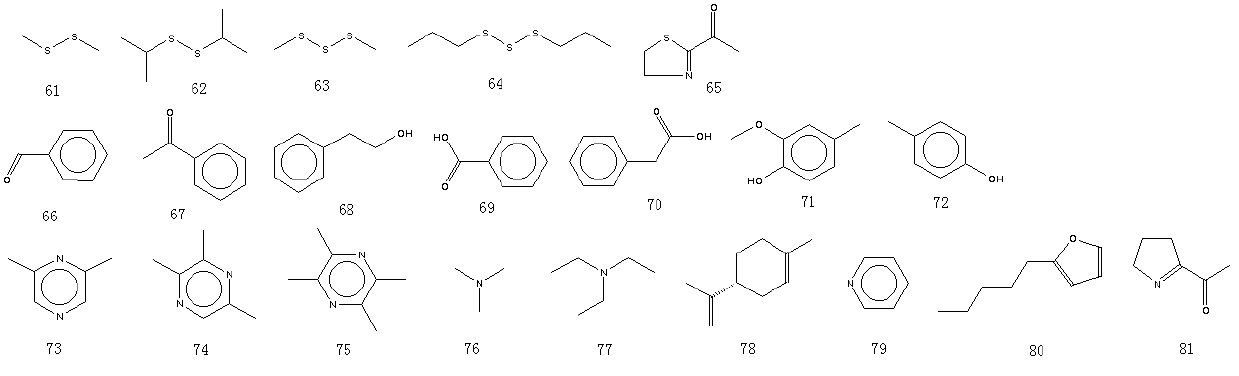
Figure 4. Structures of the sulfides, benzene series compounds, pyrazines and other compounds in Jinhua ham.